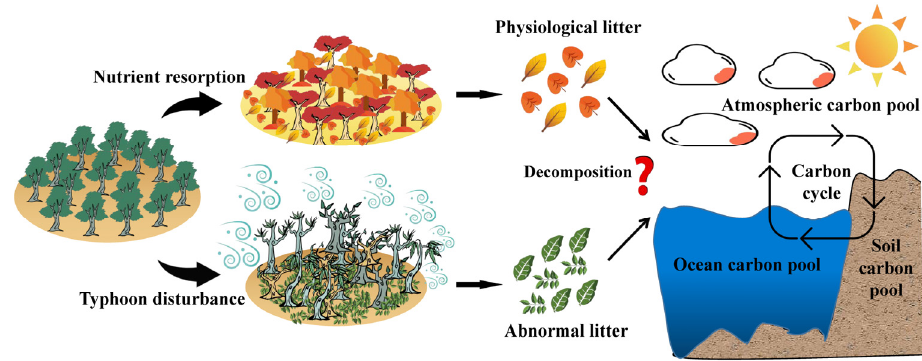
Figure 1. The conceptual diagram depicts the lack of nutrient resorption processes in typhoon‐induced abnormal litter, leading to changes in the litter’s initial substrate quality, with cascading effects on the ecosystem carbon cycle.